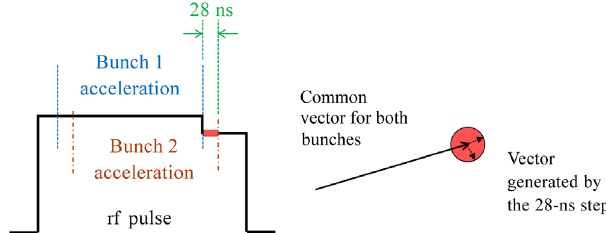
FIG. 3. LLRF strategy to tune the second bunch by introducing a step in the amplitude and the phase of the input rf pulse. The right plot is the vector representation of the method for the TW structures. The relevant region of the rf pulse for the first or for the second bunch acceleration corresponds to the filling time of the